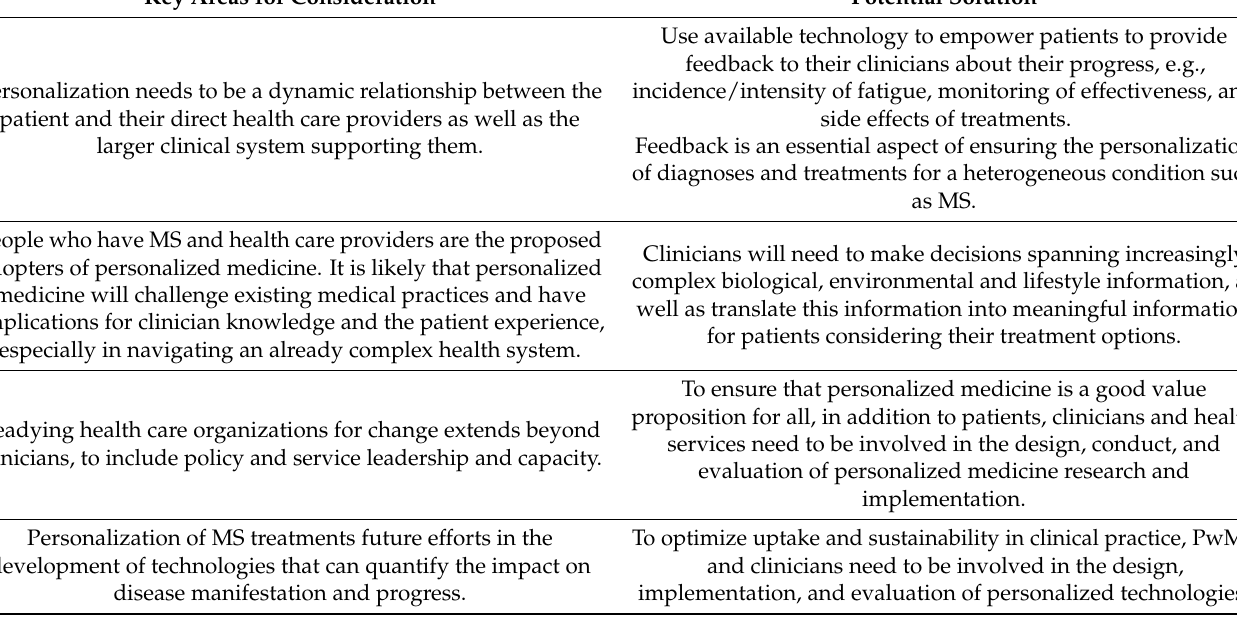
Table 2. A summary of the implications of personalized medicine and technologies for the health care system. Key Areas for